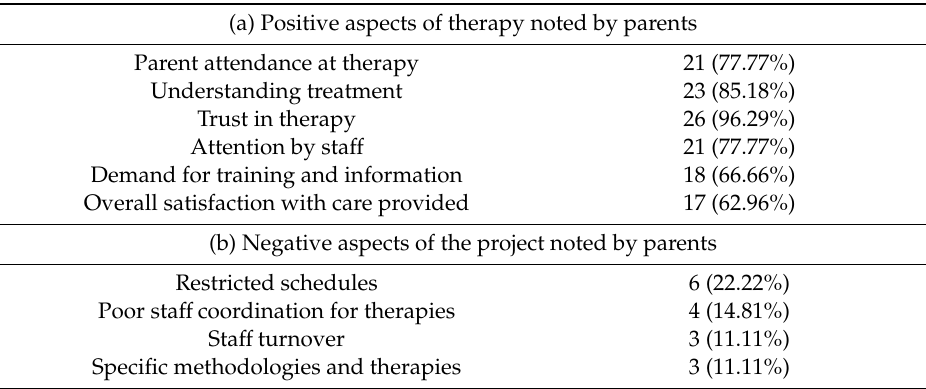
Table 3. Parents’ perceptions of therapy ( n =